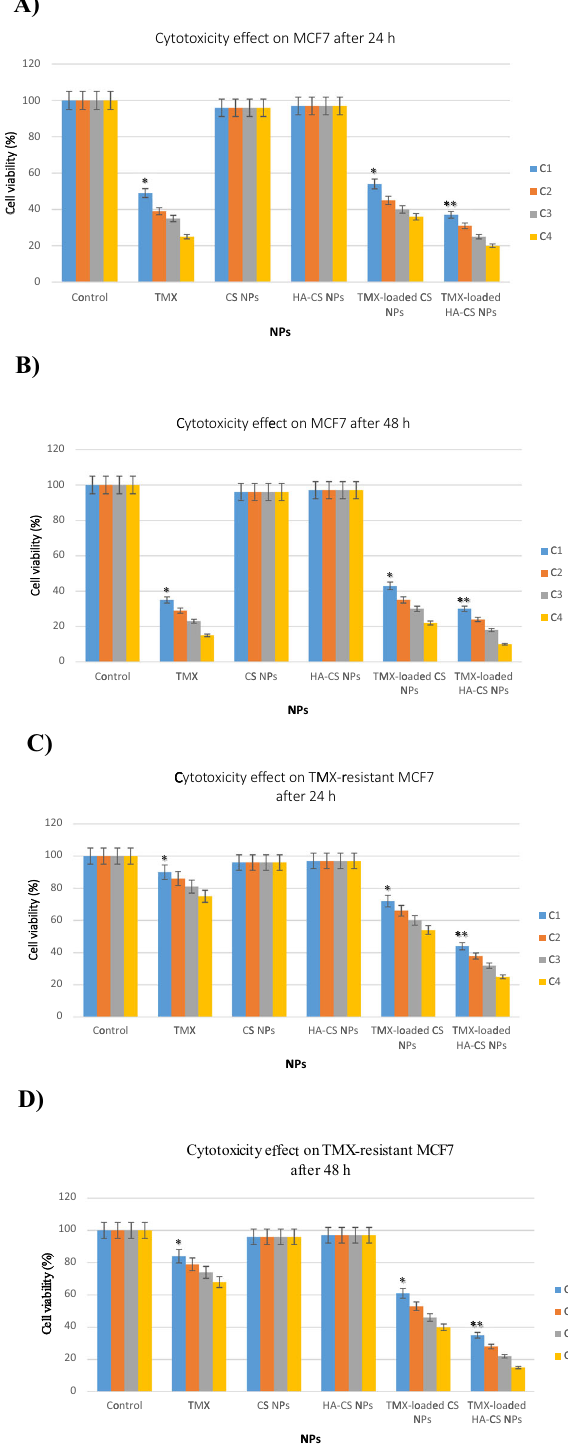
Fig. 4 Cytotoxicity of free TMX, CS NPs, HA-CS NPs, TMX-loaded CS NPs, and TMX-loaded HA-CS NPs against MCF7 ( A , B ) and TMX-resistant MCF7 ( C , D ) cell lines after 24 and 48 h at different concentrations (C1: 3 µg/ml; C2: 6 µg/ml; C3: 12 µg/ml; C4: 24 µg/ml) using MTT assay. * P < 0.05, ** P < 0.001, as assessed by Student ’ s t test or one-way ANOVA followed by Tukey post hoc test (comparing between more than two